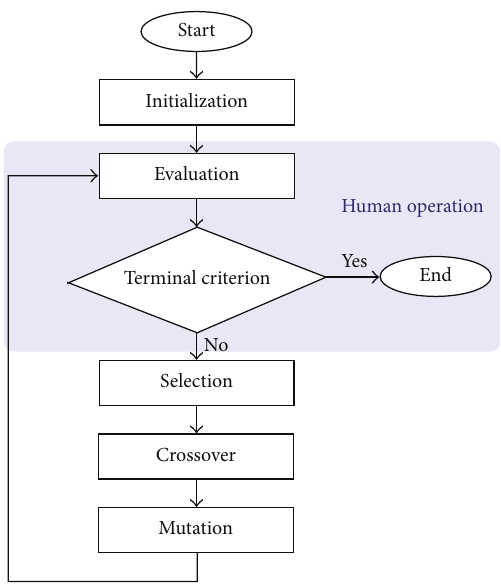
Figure 2: Flowchart of iGA